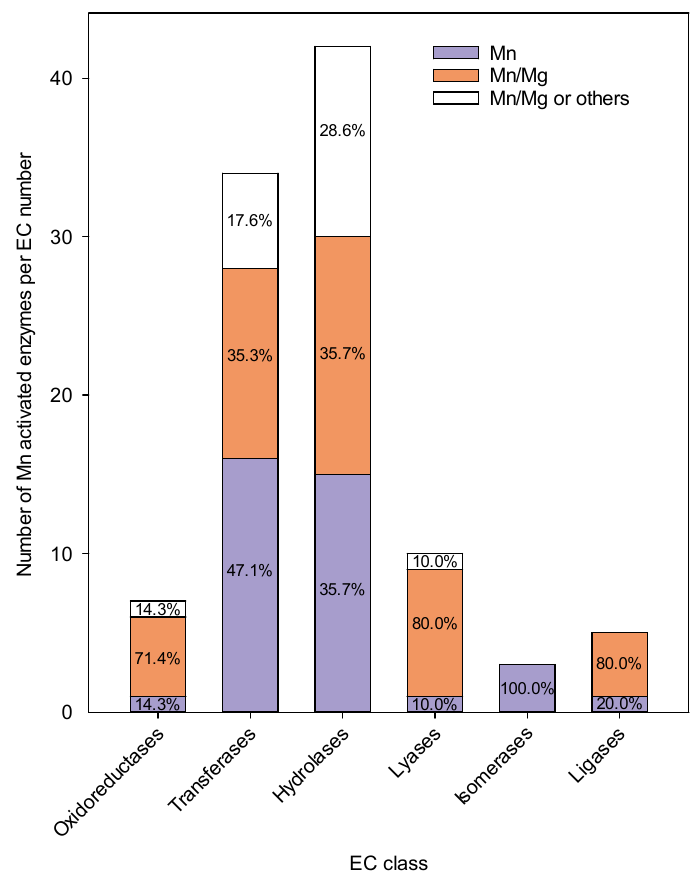
Figure 2. Distribution of Mn activated enzymes across the six Enzyme Commission (EC) classes together with the relative frequencies (%) of the coordinated metal ion for each EC class. A total of 101distinct Mn activated enzymes is described in the UniProt Knowledgebase for Arabidopsis thaliana , when filtered by reviewed records, accessible cofactor information, and protein name. Of these enzymes, 37 exclusively contain Mn as a cofactor, 44 enzymes are activated by either Mn or Mg, while 20 enzymes are reported to coordinate with Mn, Mg, or other divalent metals (Ca, Zn, Fe, Co, Ni,